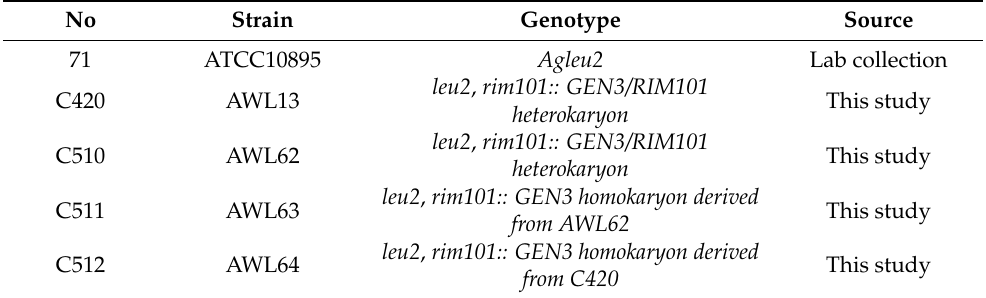
This study This study